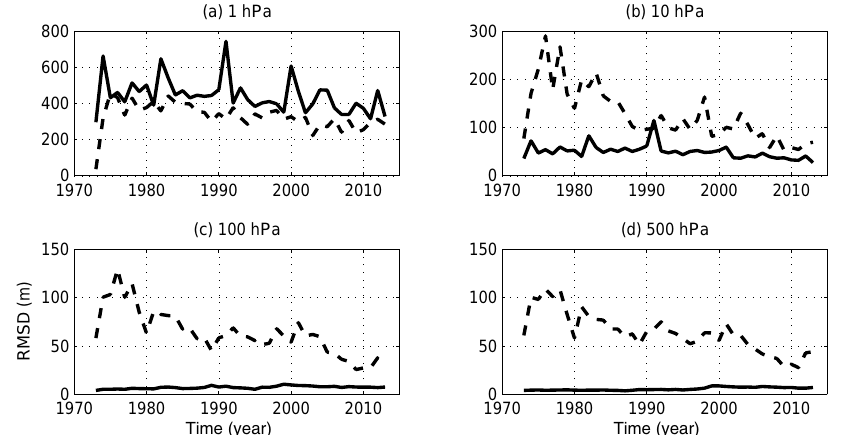
Figure 12. Year-to-year variations of RMSD at four levels as indicated. Solid lines denote results in NH for DJF, and broken lines denote results in SH for